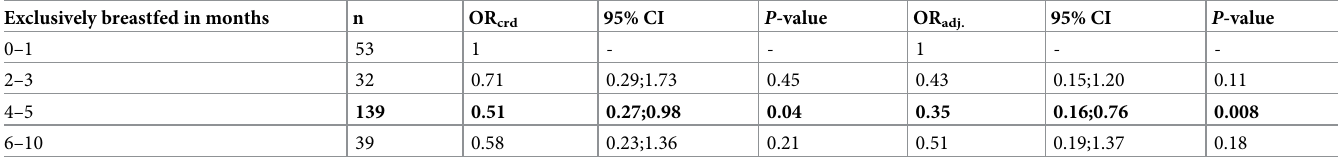
Table 2. Picky eating behaviour by infant exclusively